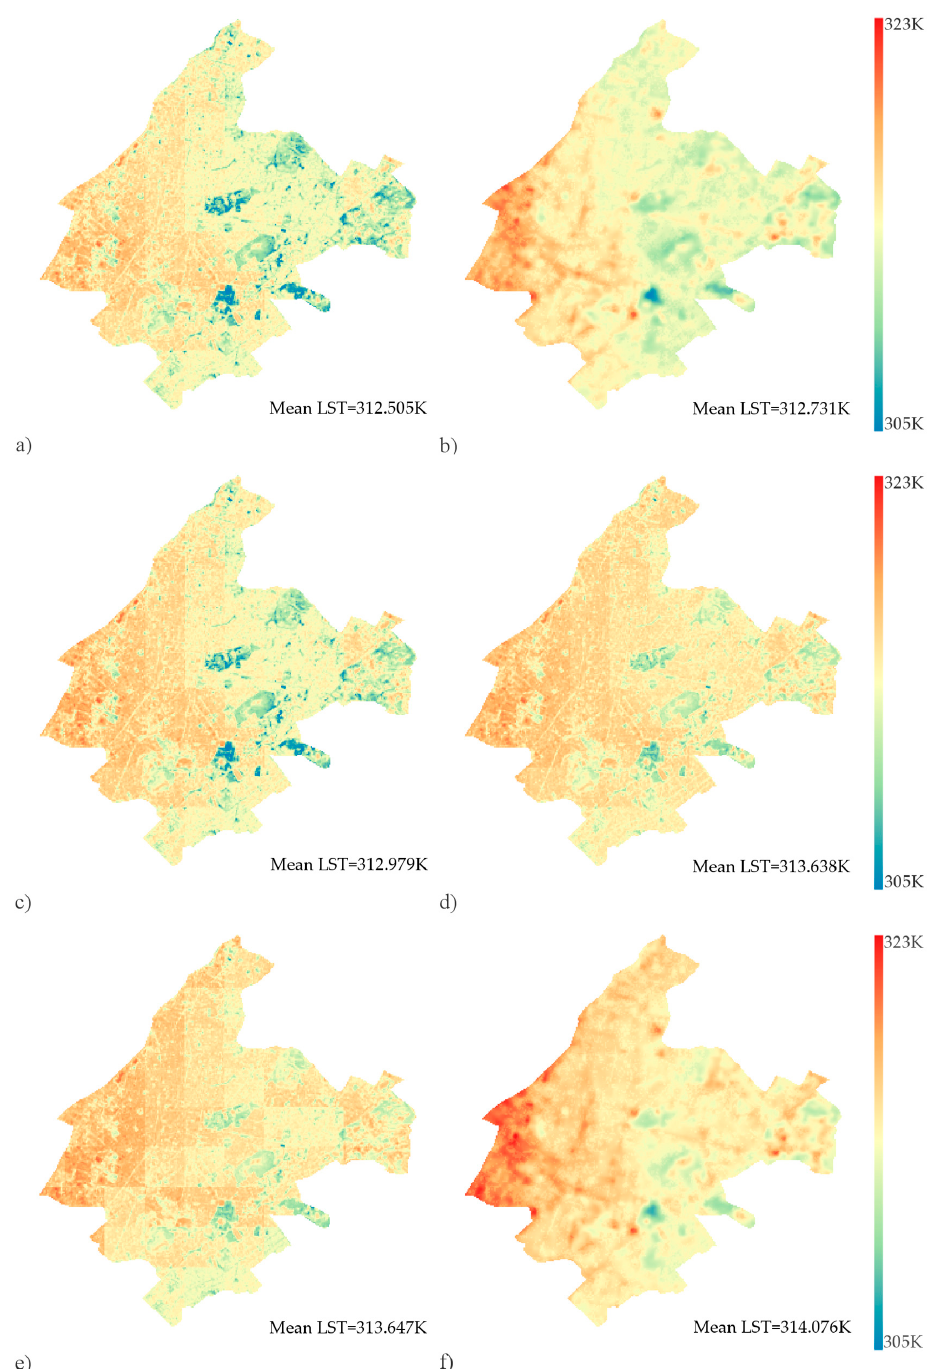
Figure 4. Land surface temperatures of the municipality of Athens for ( a ) 26/7/2016 (downscaled)—no available Landsat image, ( b ) 27/7/2016 (Landsat), ( c ) 28/7/2016 (downscaled)—no available Landsat image ( d ) 2/8/2016 (downscaled)—no available Landsat image ( e ) 11/8/2016 (downscaled)—no available Landsat image and ( f ) 12/8/2016 (Landsat).